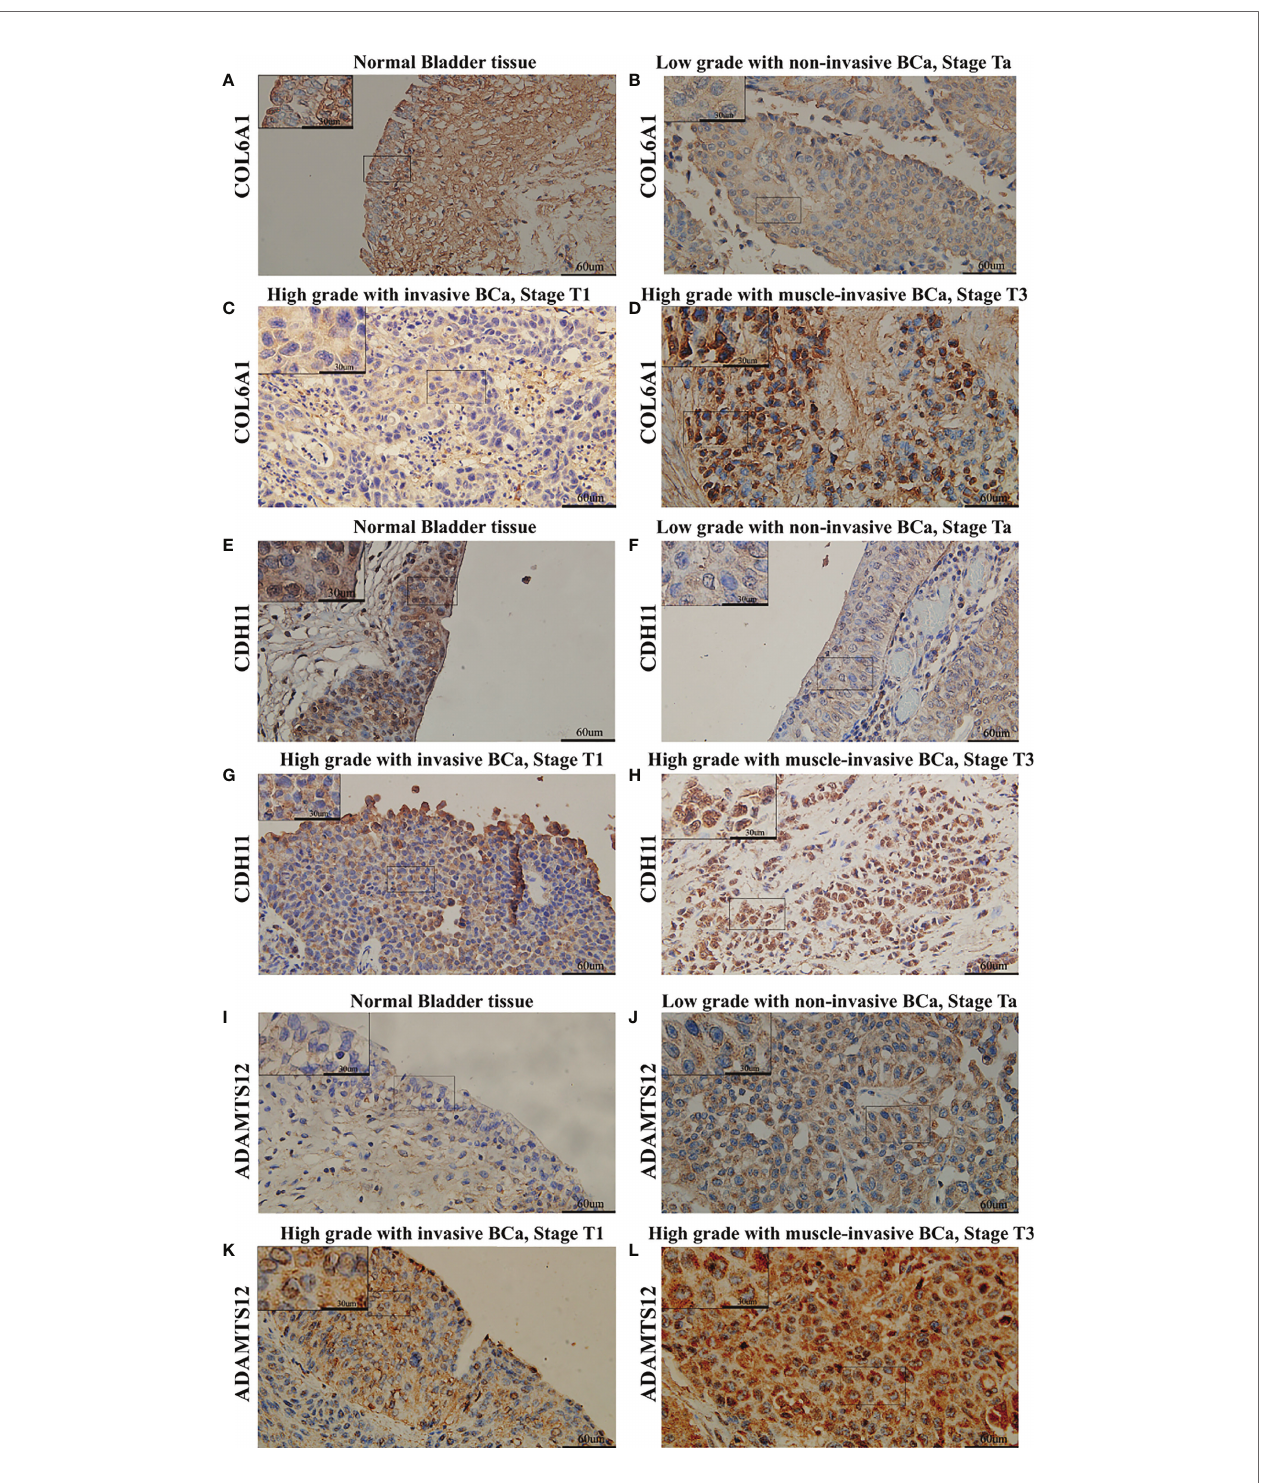
FIGURE 7 | Expression of COL6A1, CDH11, and ADAMTS12 was measured using IHC in BCa tissues divided into different groups. (A) Expression of COL6A1 in normal bladder tissue. (B) Expression of COL6A1 in low grade with non-invasive BCa, Stage Ta. (C) Expression of COL6A1 in high grade with invasive BCa, Stage T1. (D) Expression of COL6A1 in high grade with muscle-invasive BCa, Stage T3. (E) Expression of CDH11 in normal bladder tissue. (F) Expression of CDH11 in low grade with non-invasive BCa, Stage Ta. (G) Expression of CDH11 in high grade with invasive BCa, Stage T1. (H) Expression of CDH11 in high grade with muscle- invasive BCa, Stage T3. (I) Expression of ADAMTS12 in normal bladder tissue. (J) Expression of ADAMTS12 in low grade with non-invasive BCa, Stage Ta. (K) Expression of ADAMTS12 in high grade with invasive BCa, Stage T1. (L) Expression of ADAMTS12 in high grade with muscle-invasive BCa, Stage